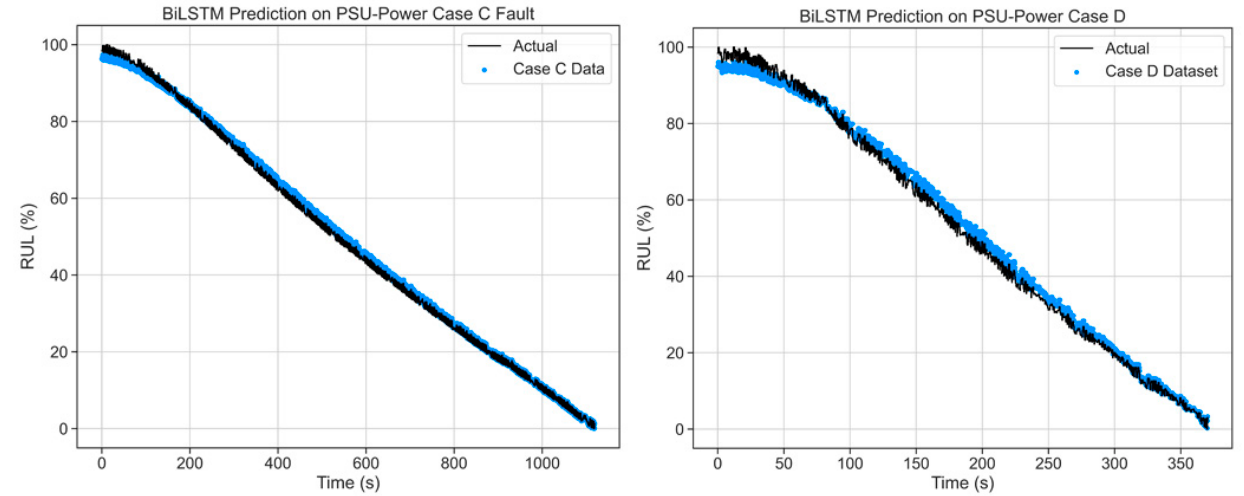
Figure 10. RUL prediction using the BiLSTM Model.